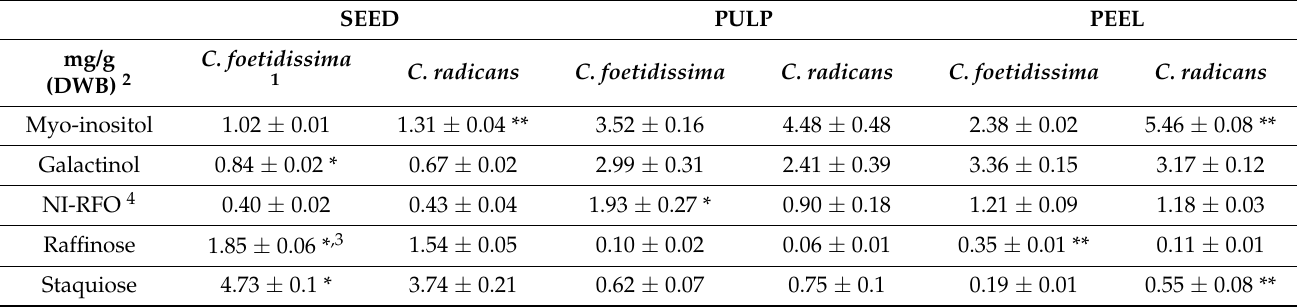
Table 6. Determination of raffinose family oligosaccharides (RFOs) in Cucurbita foetidissima and C. radicans fruits collected in the wild. RFO levels were measured in fruits collected from C. foetidissima and C. radicans plants collected in the wild from sites localized in the state of Jalisco,